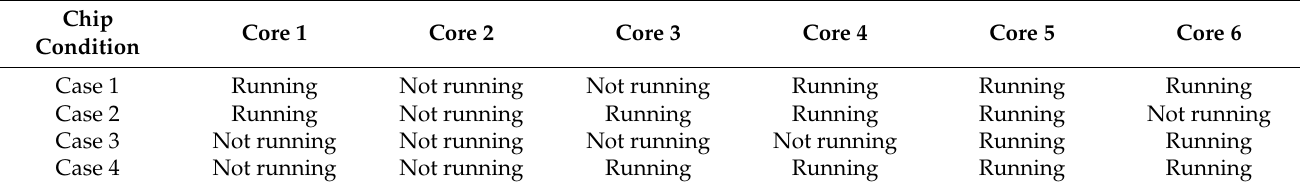
Table 1. Chip operating conditions.